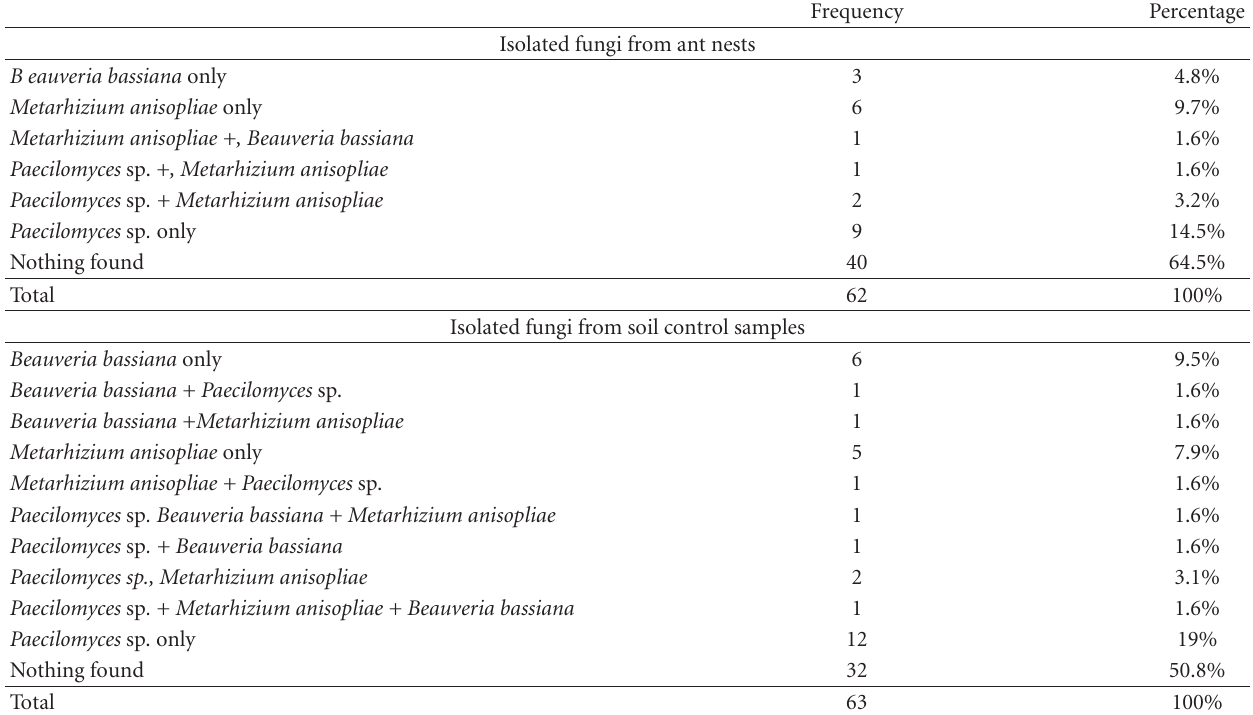
Table 3: Frequency of isolated fungi from ant nests and soil control samples.